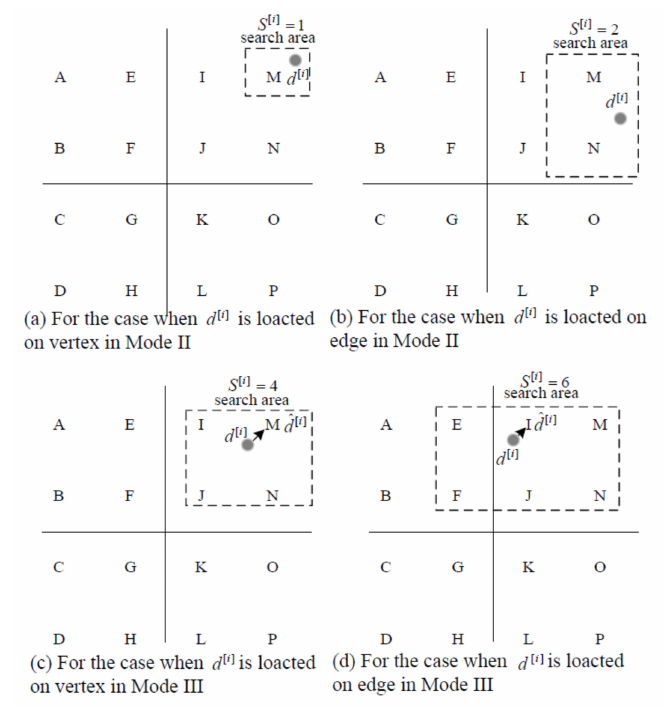
Figure 6. Examples of the special cases of the proposed limited search